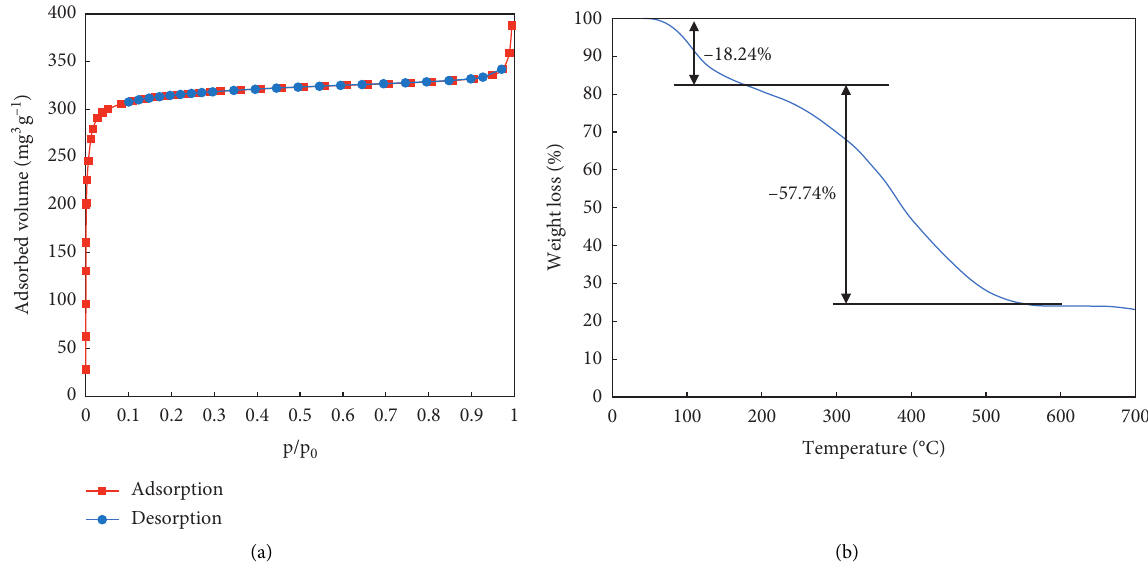
Figure 3: TGA diagram and nitrogen adsorption isotherm of the prepared UiO-66-NO